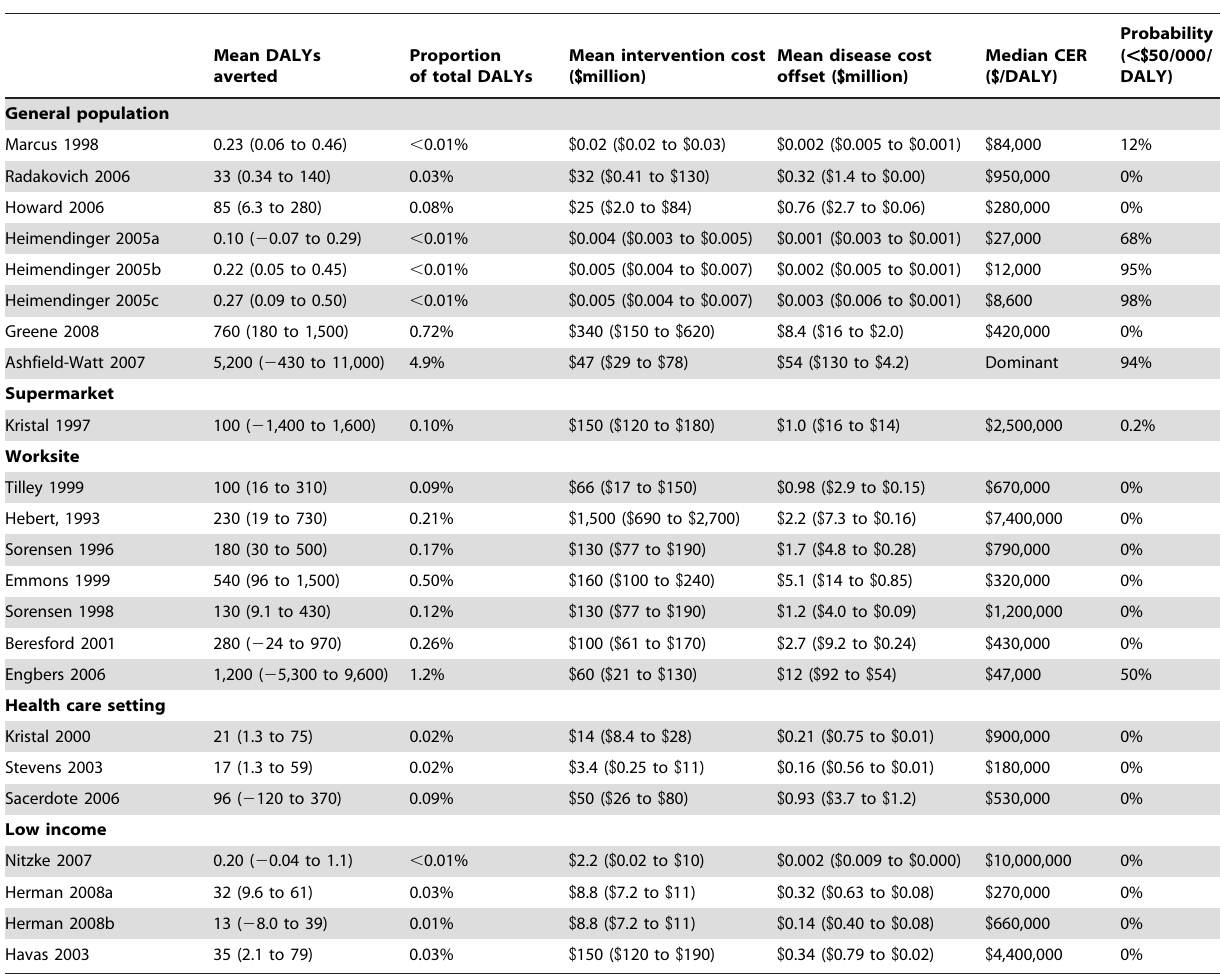
Table 4. Health gain, costs and cost-effectiveness of the interventions to promote fruit and vegetable